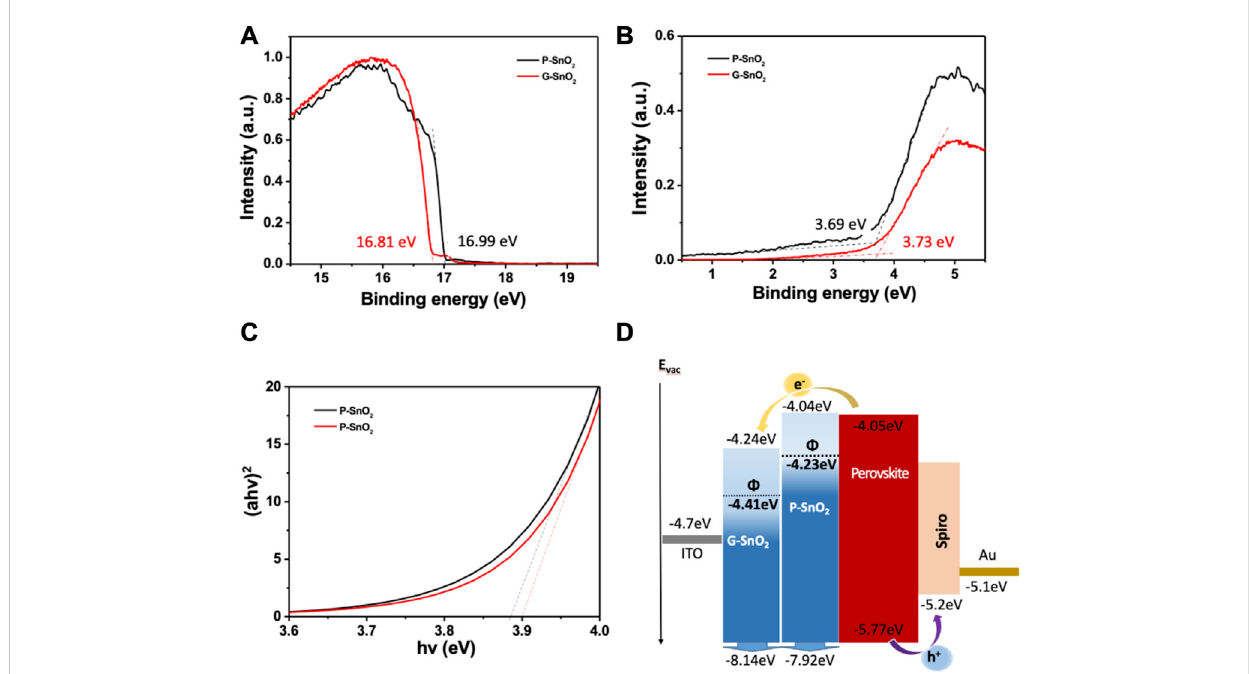
FIGURE 2 (A,B) UPSmeasurementson thepristine(P-SnO 2 )andguanidinedoped(G-SnO 2 ) fi lmsdepositedonITO, (A) secondaryedgeregion; (B) Fermilevel determination. (C) Tauc plot of P-SnO 2 and G-SnO 2 fi lms deposited on ITO glass. (D) Energy level diagram derived from photoelectron and UV-vis absorption spectroscopy.